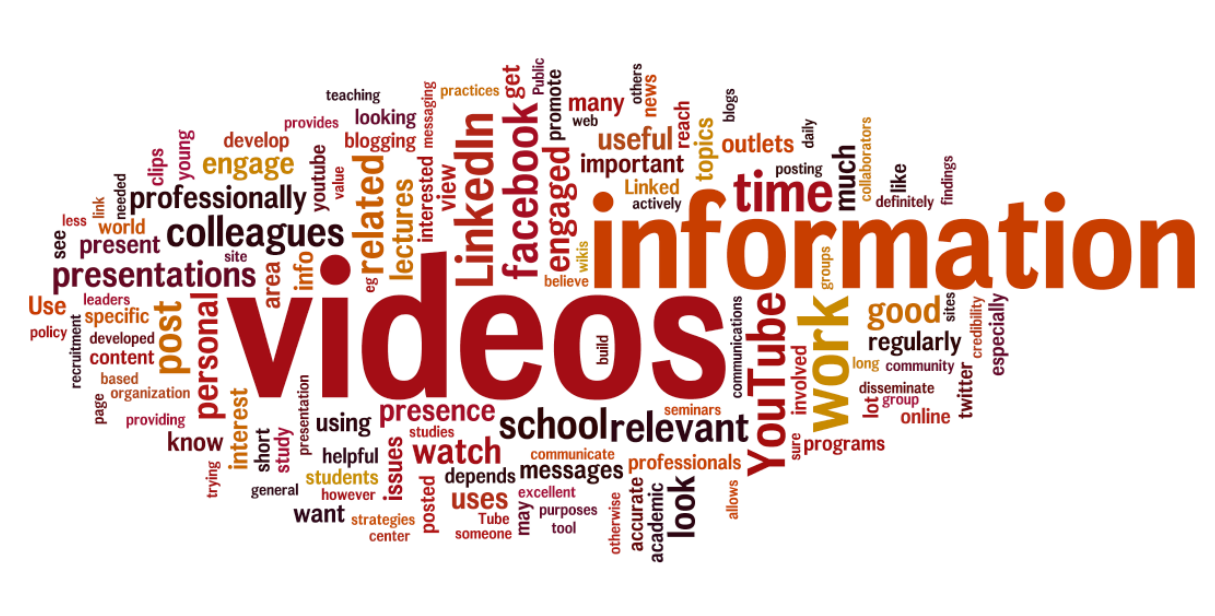
Figure 1. A “Wordle” diagram of survey responses on current and desired uses of social media in public health research and